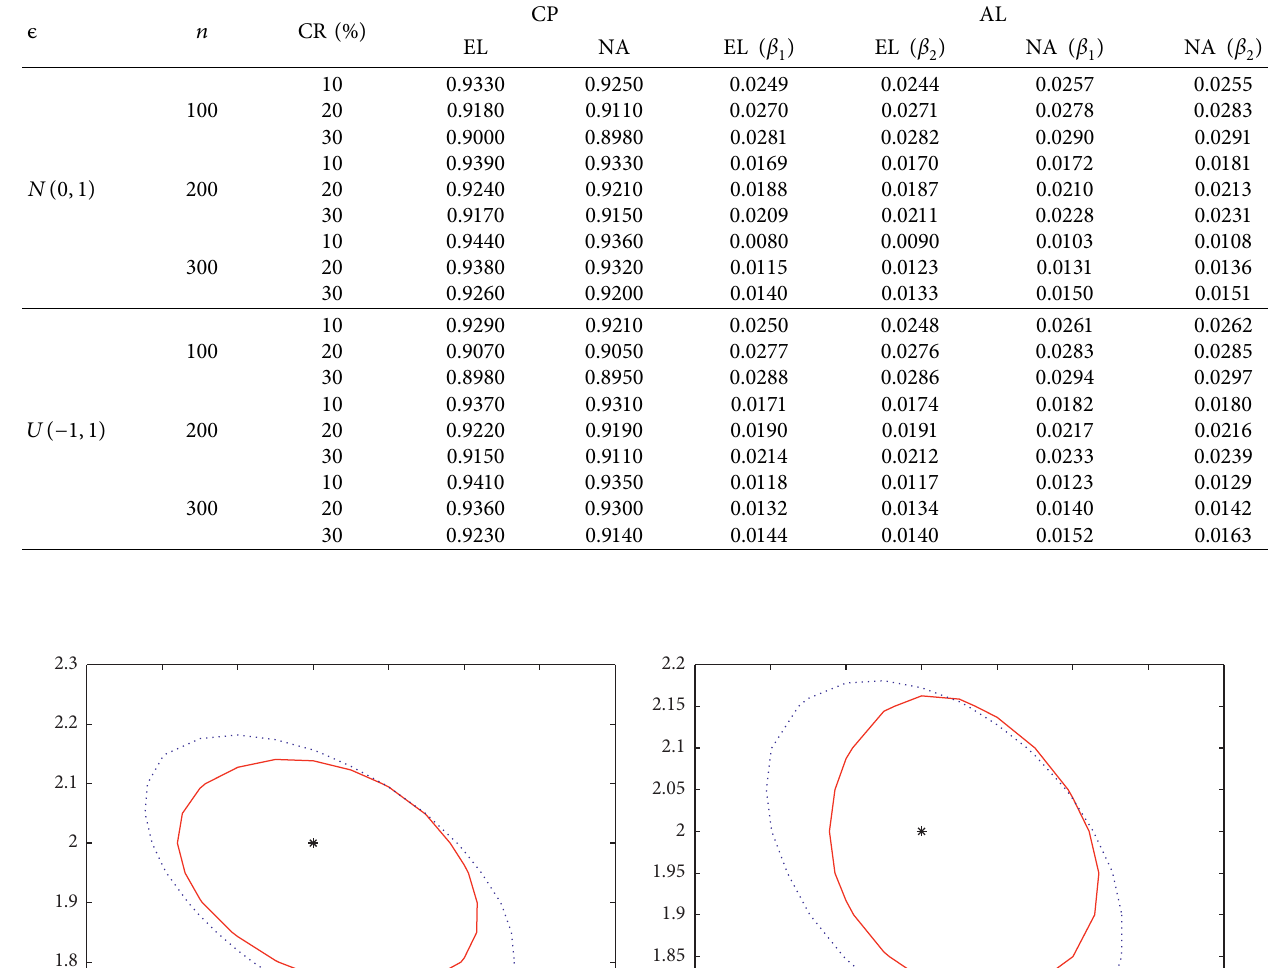
Table 1: The coverage probabilities (CPs) and average lengths (ALs) of the confidence intervals based on the EL and NA methods with nominal level 1 − α �